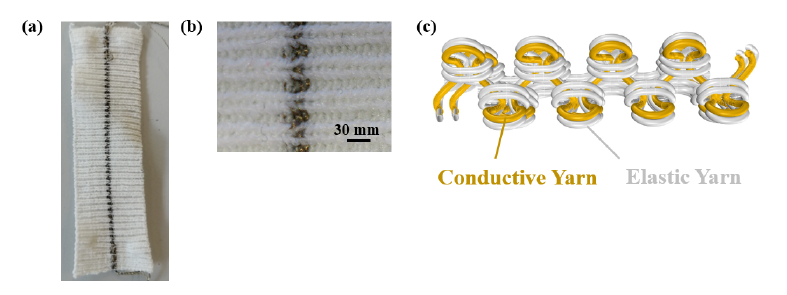
Figure 1. ( a ) The developed knitted strain sensor, ( b ) optical images of the sensing region which shows the conductive yarns (gold) positioned inside and elastic yarns outside (white), and ( c ) illustration of the conductive and elastic yarn positioning within the sensing region.